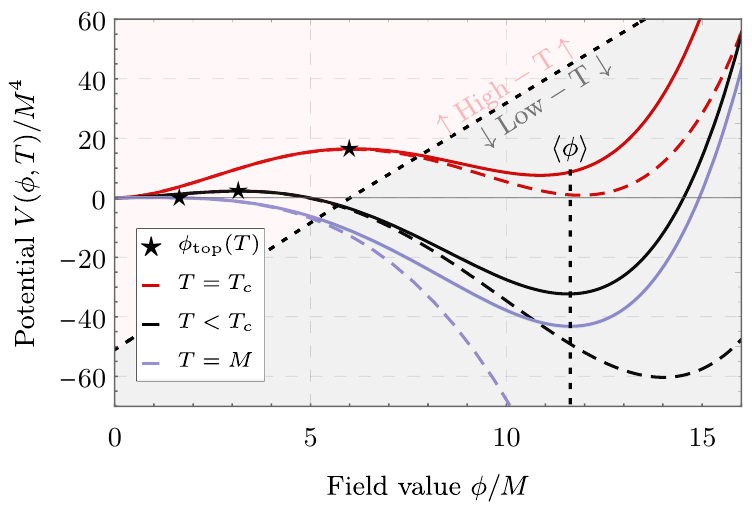
Figure 1 . Heuristic view of the Coleman-Weinberg potential V ( φ, T ) from eq. (3.1), for varying temperatures. Solid curves are the full numerical temperature corrected potential and dashed curves are the high T expanded potential in eq. (3.5). The high T approximation works well near the meta- stable vacuum and near φ top ( T ) , while not capturing the full behavior for large field values near the true vacuum h φ i . Here, we show the potential for g = 1 and M = 1 GeV, for which T c ' 3 . 8 GeV. of N b real scalars coupled through quartic interactions with strength ˜ g 2 . For simplicity,